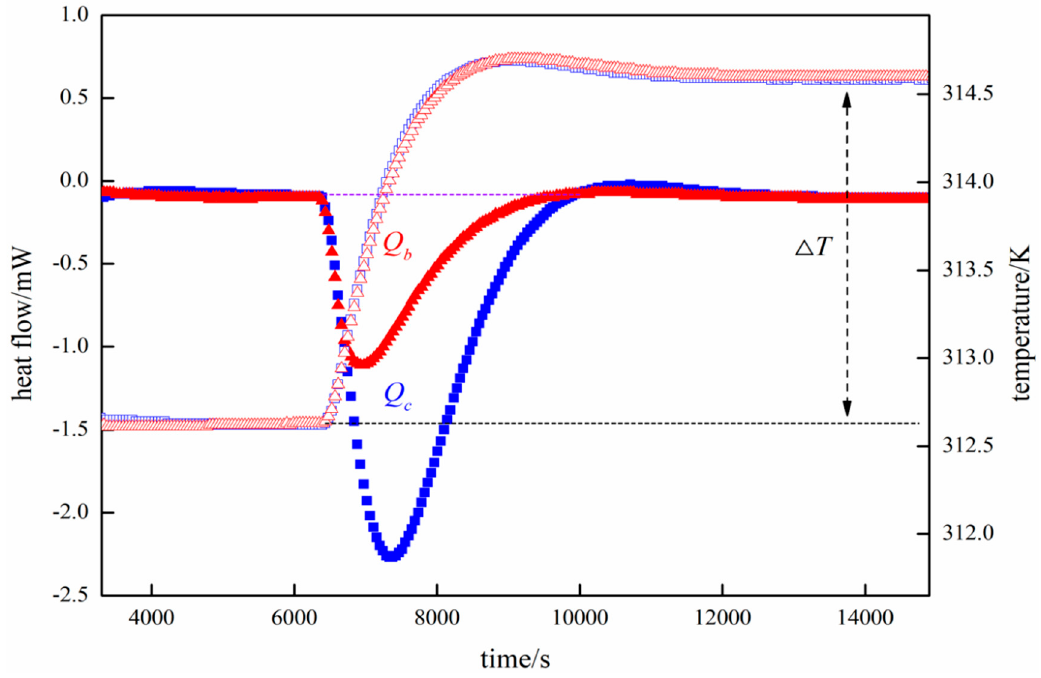
Figure 2. Illustration of C p measurement with the C80 for a catalytic material. ■ , heat flow_H-ZSM-5-23; ▲ , heat flow_blank; □ , temperature_H-ZSM-5-23; △ , temperature_blank.